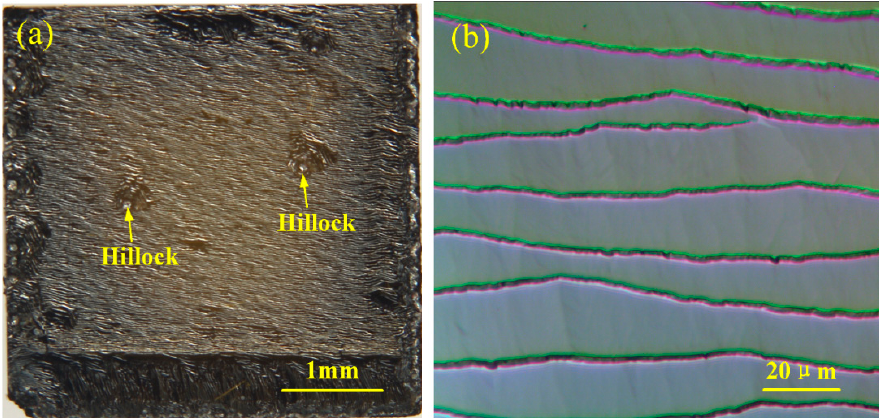
Figure 4. Optical images of Sample C. ( a ) Sample after growth with 15× magnification (LEICA M205 A) and ( b ) the surface morphology of step ‐ flow growth with a 400× magnification (KEYENCE VHX ‐ 600).